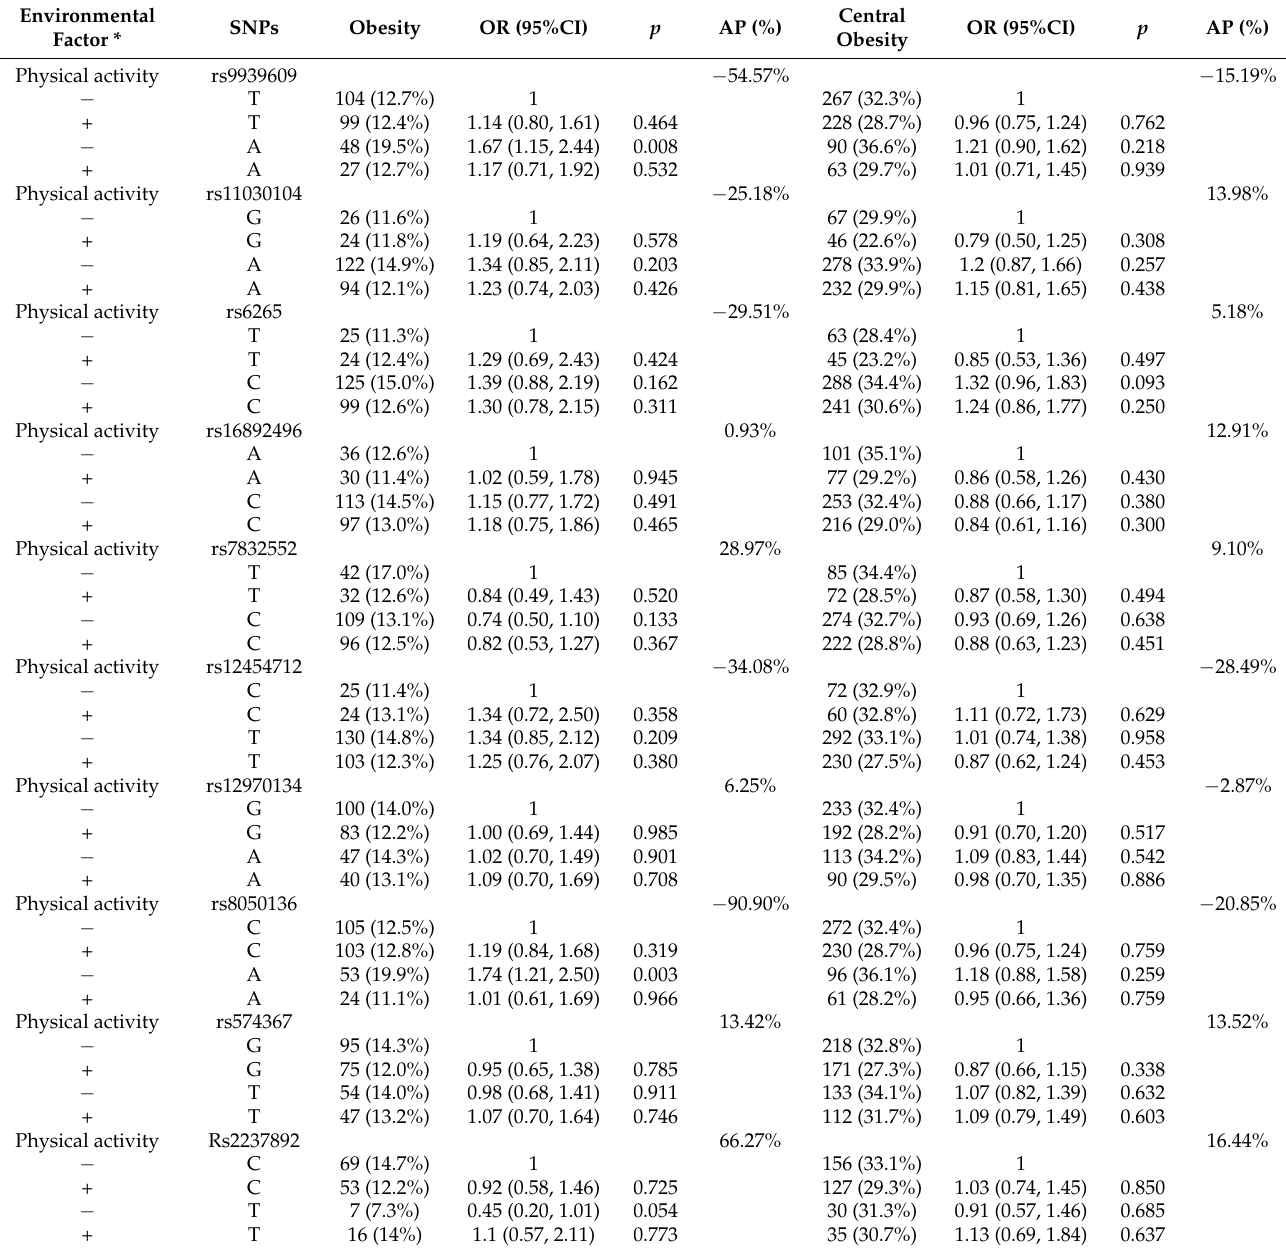
Table 4. The interaction between physical activity and SNPs in obesity and central